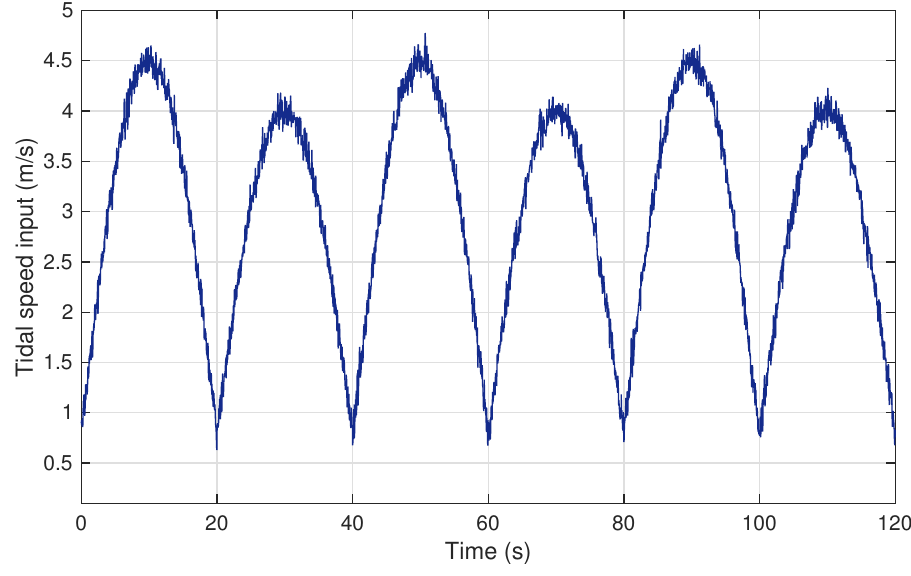
Figure 16. Case 1: Regular turbulent tidal resource speed.